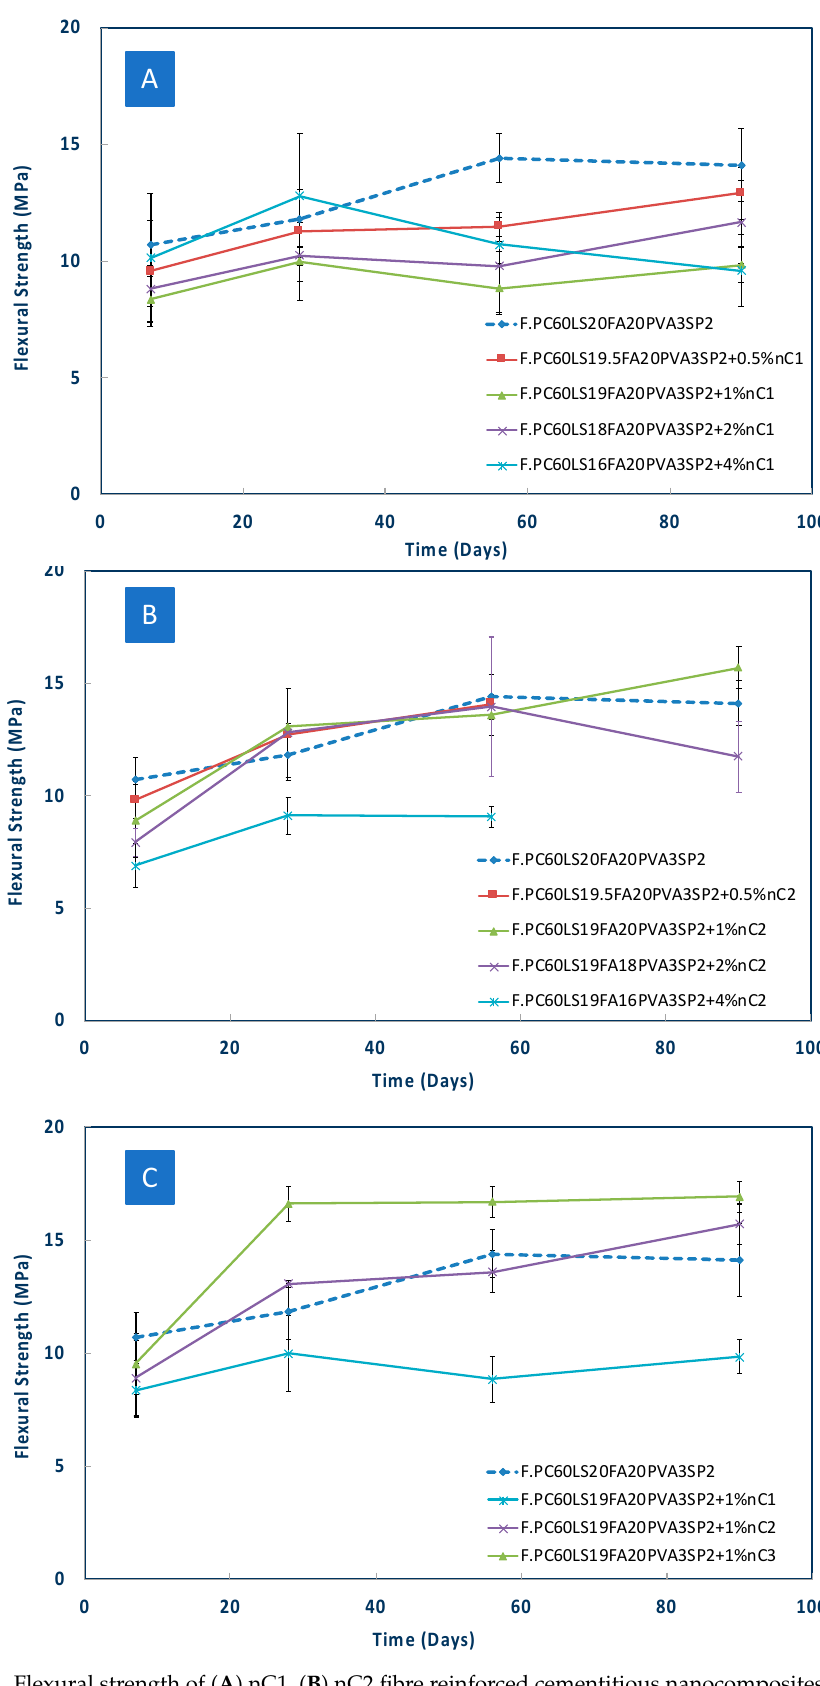
Figure 6. Flexural strength of ( A ) nC1, ( B ) nC2 fibre reinforced cementitious nanocomposites based on F.PC60LS20FA20PVA3SP2 ( C ) comparison of flexural strength of 1% nC1, nC2 and nC3 fibre reinforced cementitious nanocomposites.